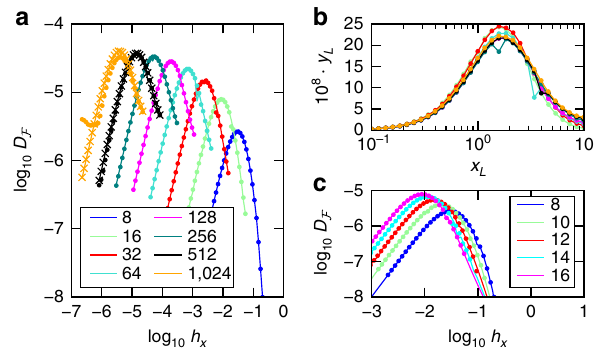
Figure 4 | Interaction distance D F for the FM Ising model calculated from the density matrix renormalization group. ( a ) DMRG results retaining w states for w ¼ 32 (dots), 64 (lines) and 128 (crosses) states. The result is already converged for w ¼ 64 for the biggest system size L ¼ 1,024. ( b ) Scaling collapse according to ansatz (4) with the critical exponents n E 0.533, z E (cid:3) 1.4 and saturation parameter y E 0.025. The collapsed variables x L ¼ ( g (cid:3) g c ) L 1/ n and y L ¼ D F 1 = L þ y ð Þ (cid:3) z . ( c ) Comparison between D F calculated for entanglement spectra provided via DMRG (points), for w ¼ 16 entanglement levels, and exact diagonalization (lines) for the same system. The results for these system sizes accessible by exact diagonalization agree. All results in this figure are calculated for open boundary conditions where DMRG is most